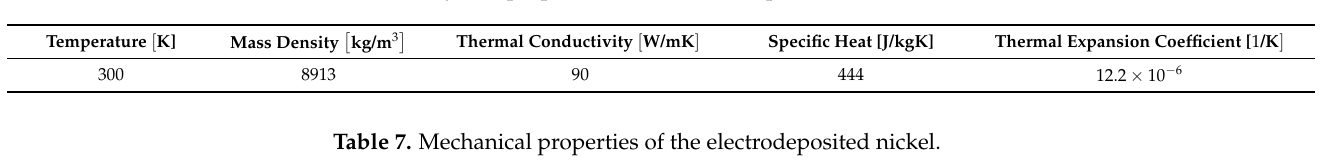
Table 6. Physical properties of the electrodeposited nickel.